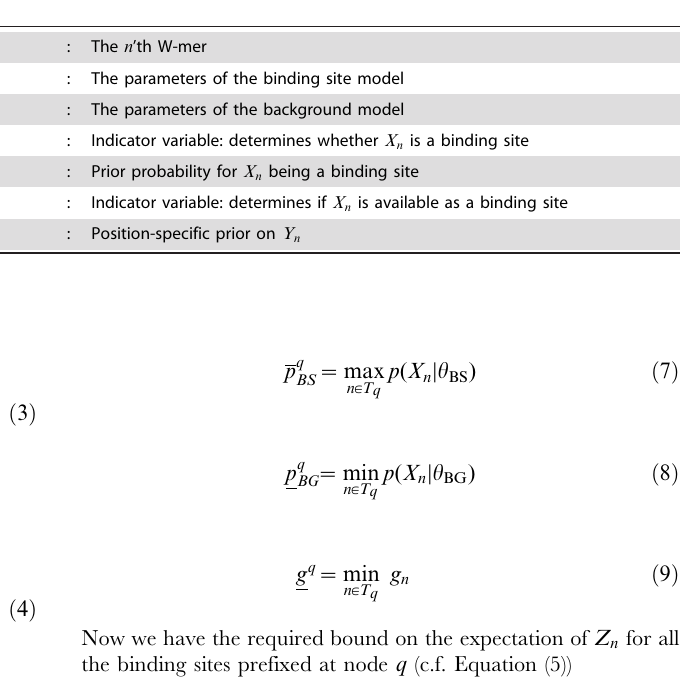
Table 3. The parameters of our